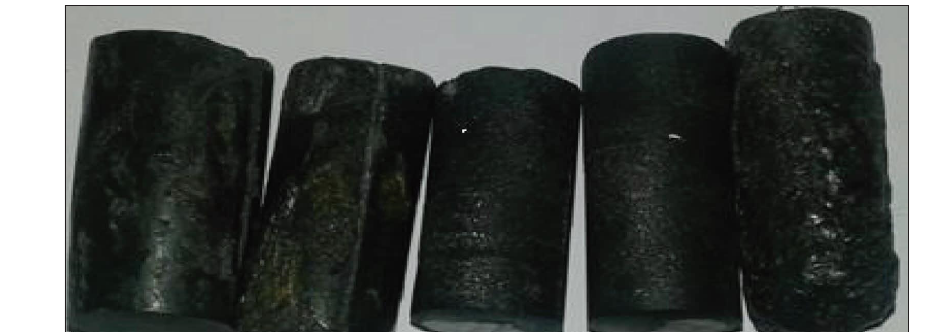
Figure 10: Samples for wear test.